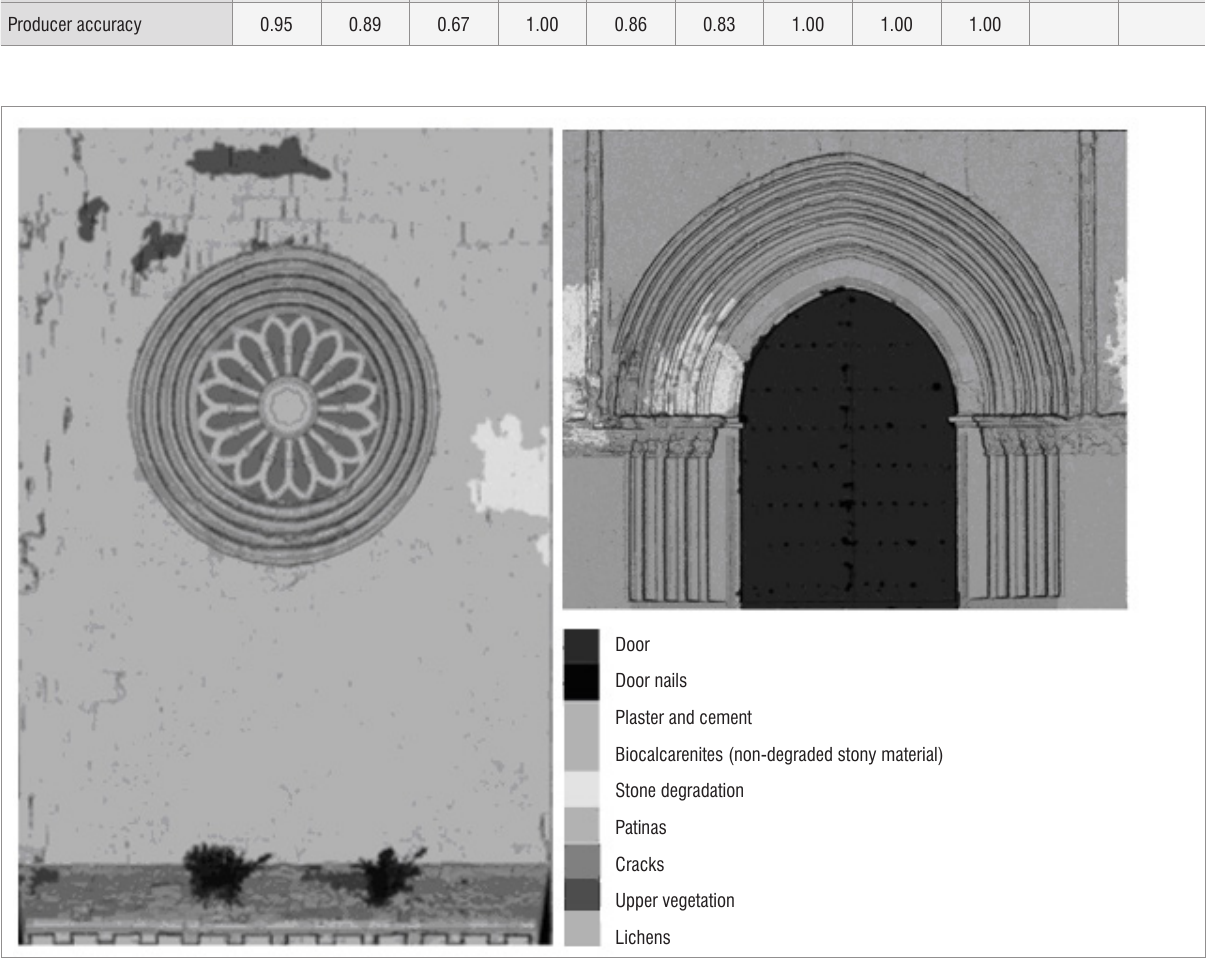
Figure 7: Object-oriented classifications of the rosette (left) and of the main door (right) of the Santa Marina